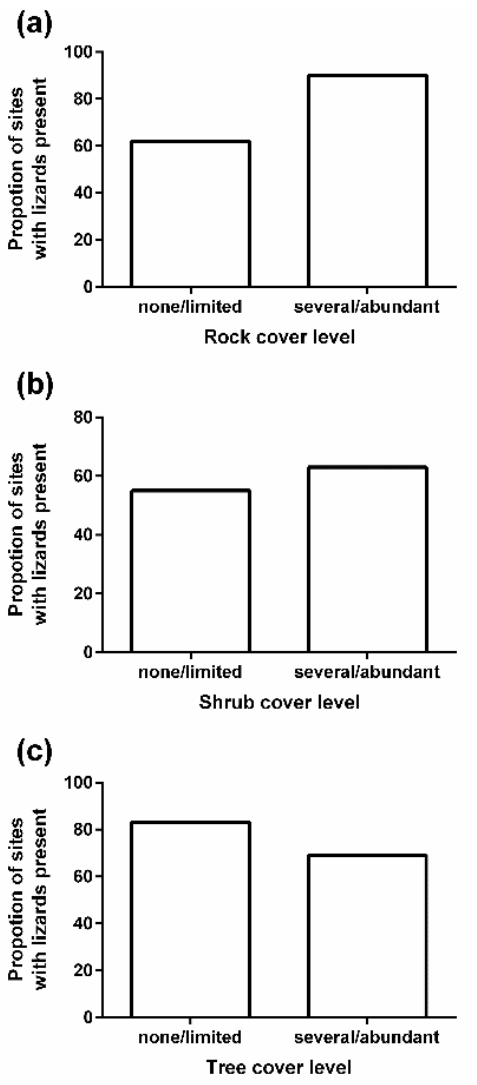
Figure 2. Proportion of sites with lizards present with respect to ( a ) rock cover, ( b ) shrub cover, and ( c ) transect-level tree cover. Only rock cover and tree cover appeared in the top models.